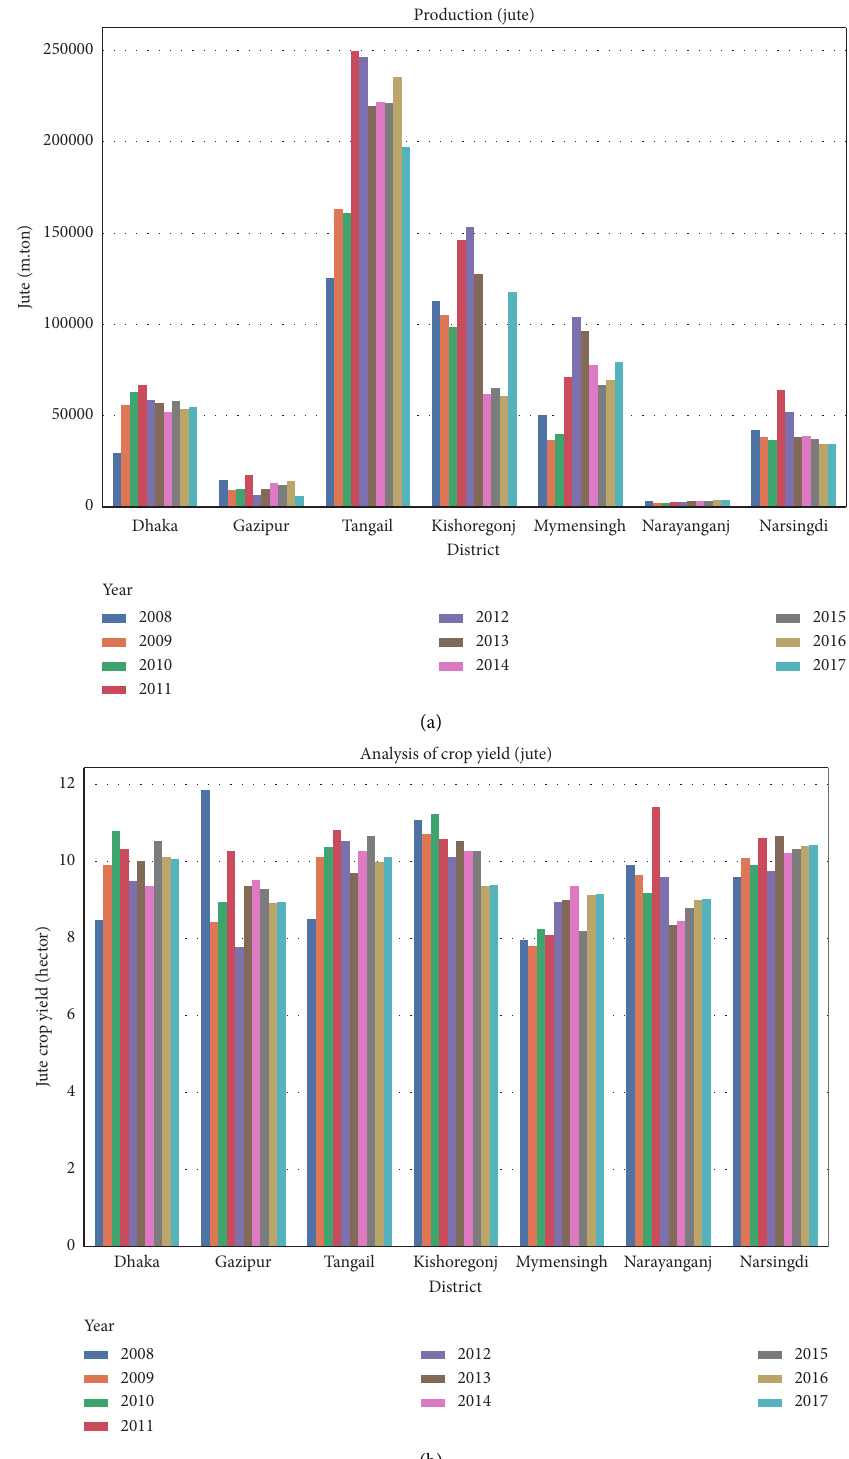
Figure 8: Data analysis of jute. (a) Crop production for jute. (b) Crop yield for